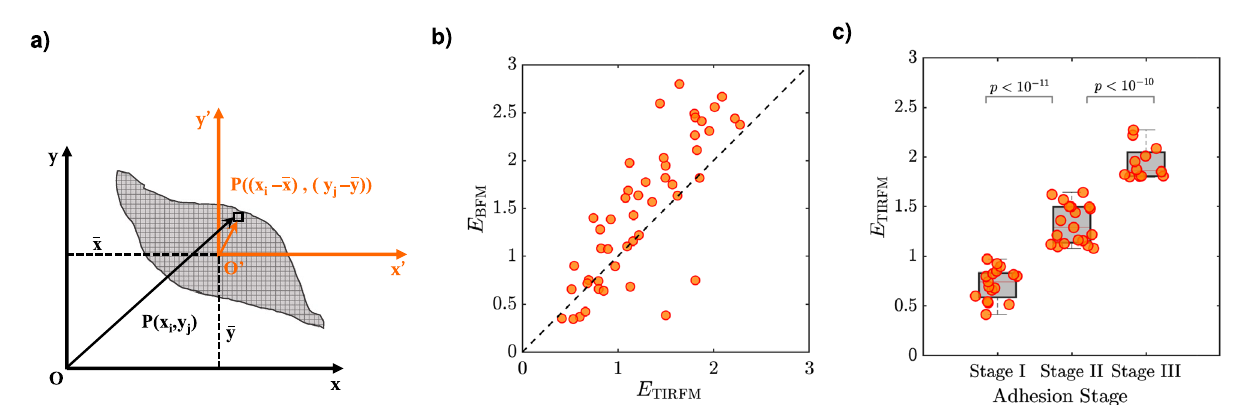
Figure 1. Quantification of sub-cellular distribution of F-actin patches at the cell’s contact-area. ( a ) Schematic diagram of a cell in the coordinate system, where, O ′ , ¯ x , and ¯ y denote the centroid, horizontal and vertical position of the centroid. Each element in the cell is identified by a pair of coordinates ( x i , y j ) or ( x i - ¯ x , y j - ¯ y ), where i , j = 1, 2, 3, . . . . ( b ) Correlation between the ‘geometrical elongation’ ( E BFM ; from BFM images) and the ‘actin elongation’ ( E TIRFM ; from TIRFM-images) of 48 single melanoma cells. ( c ) Classification of the cell adhesion stage of 48 single melanoma cells (data of panel ( b )) based on the E TIRFM value. The cell adhesion stages are the attaching stage (stage I), the spreading stage (stage II), and the expanding stage (stage